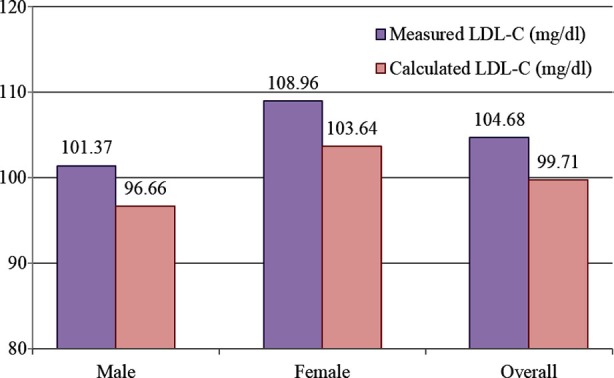
Comparison of measured and calculated LDL-C (by formula)P-value < 0.05 was considered statistically significant.P-value was found to be statistically significant in all cases.